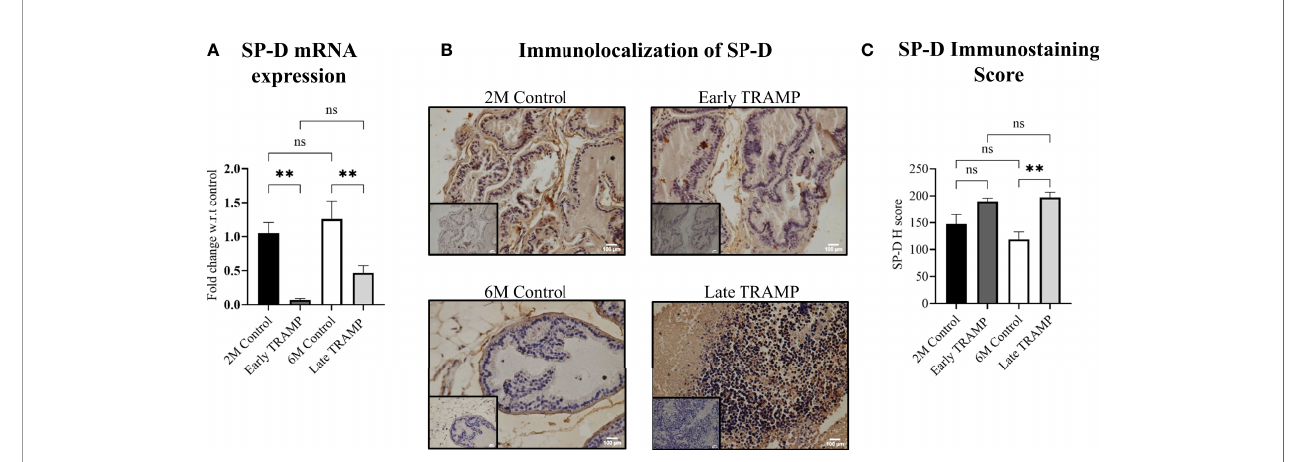
FIGURE 2 | Altered expression of SP-D mRNA and protein in the early and late stages. (A) qRTPCR of SP-D transcript in 2M Control (n= 4), Early TRAMP (n=5), 6M Control (n=5) and Late TRAMP (n=8) normalized with GAPDH. (B) Representative images of SP-D immunolocalization. (C) Semi-quantitative immunohistochemical (IHC) analysis of SP-D protein in TRAMP (early and late) and age-matched control mice. The intensity of SP-D staining was quantitated by an open source plugin, IHC pro fi ler compatible with open resource digital image analysis software, Image J followed by calculation of H score. For each tissue section, a minimum of three to four areas were scanned and average H score was calculated. The bar graphs represent the average H score of 2M Control (n= 3), Early TRAMP (n=3), 6M Control (n=4), Late TRAMP (n= 5) tissue samples. Inner boxes represent negative staining. Statistical signi fi cance was tested using one-way ANOVA followed Tukey ’ s multiple comparisons test (**p < 0.01). The data presented are mean ± SEM. ns, Non-signi fi